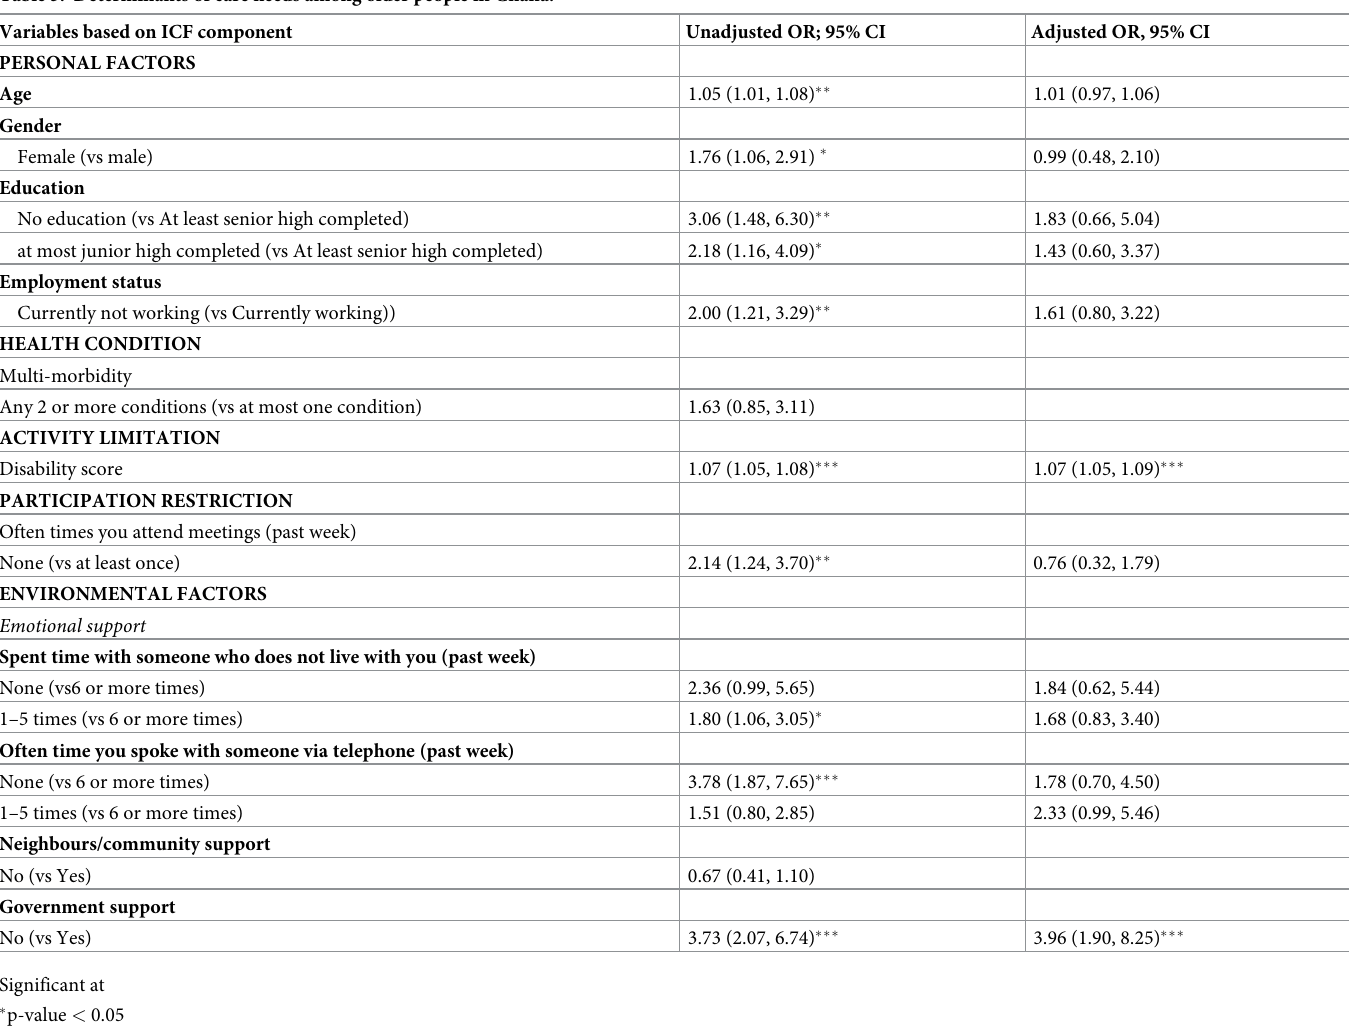
Table 3. Determinants of care needs among older people in